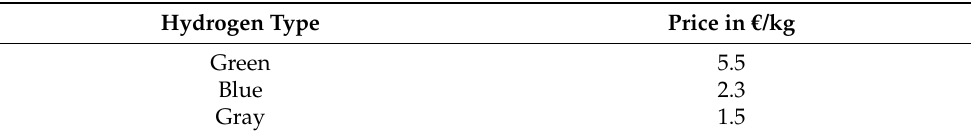
Table 10. Price of hydrogen according to S&P Global